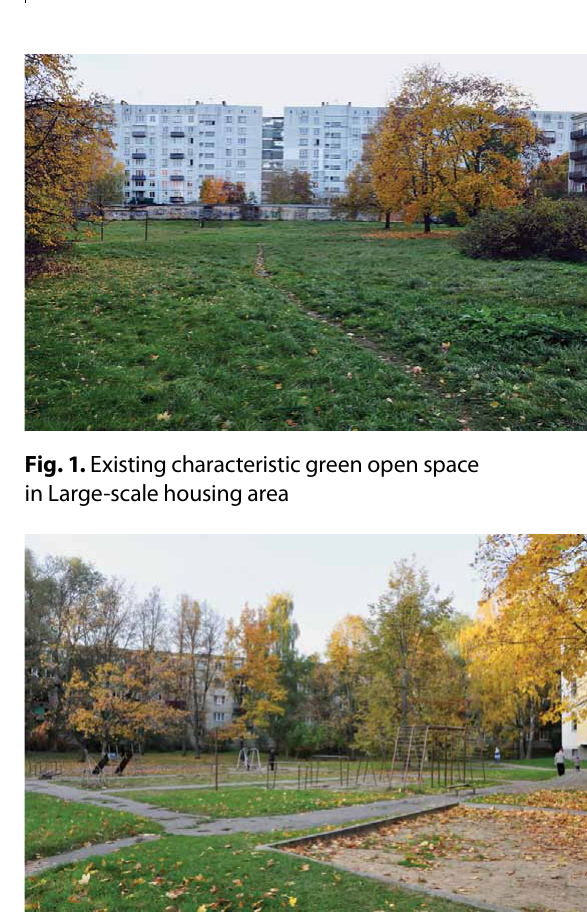
Fig. 3. average condition of equipment quality in green open areas